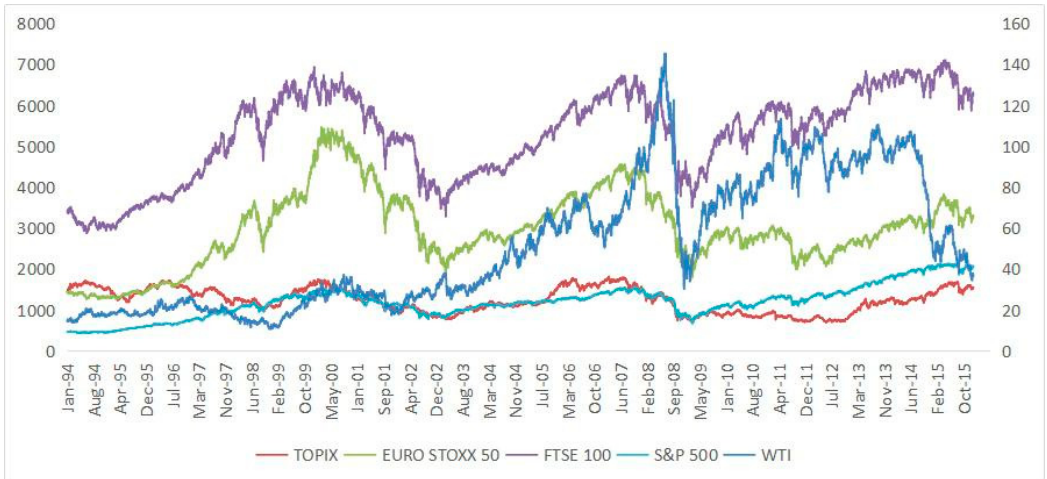
Figure 1. Plots of raw data. The left axis denotes the stock market price index, while the right axis 192 denotes the crude oil price. 193 Table 1. Summary statistics for returns on oil and stock prices. WTI: West Texas Intermediate. 194